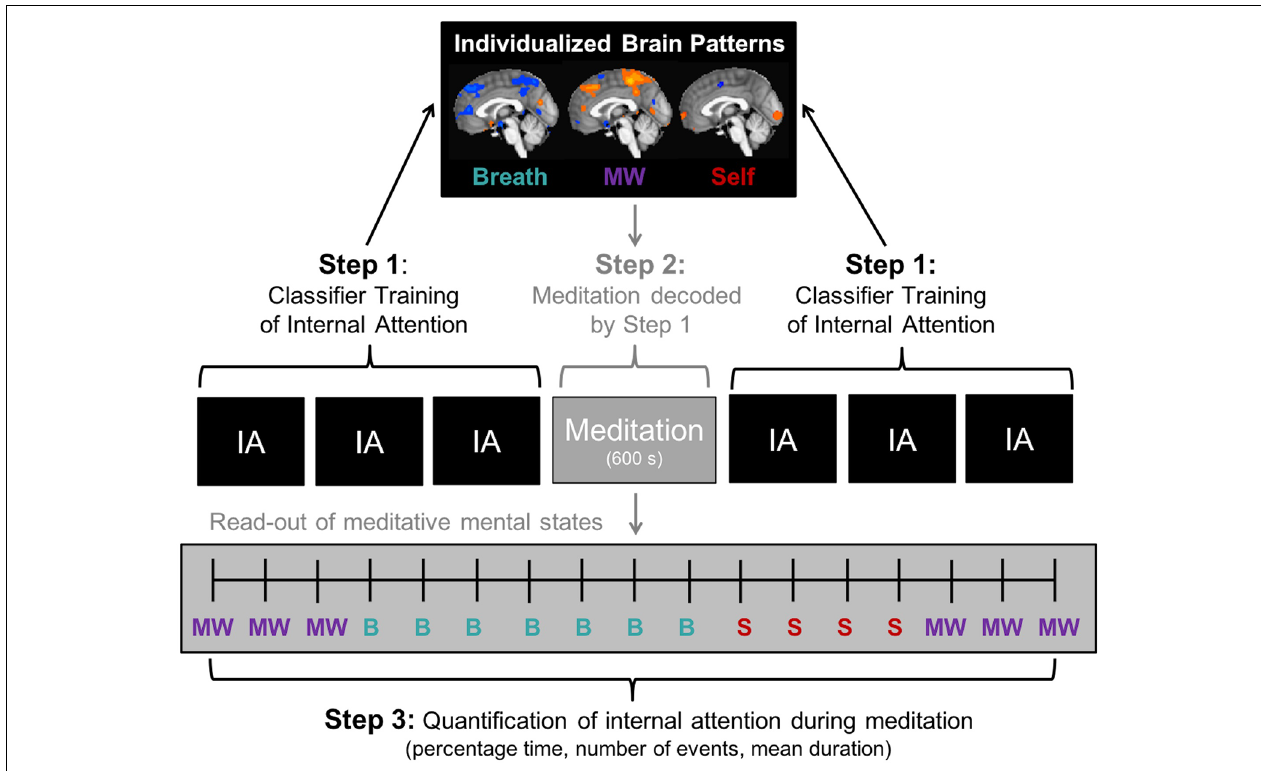
FIGURE 1 | EMBODY Framework: E valuating M ultivariate Maps of Body Awareness to measure internal attention (IA) states during meditation. Step 1 . Brain pattern classifier training. Machine learning algorithms are trained in fMRI neural patterns associated with internal mental states in the IA task. IA is directed via auditory instructions to pay attention with eyes closed to the breath, mind wandering (MW) self-referential processing (Self), and control conditions of attention to the feet and ambient sounds (see Figure 2 ). Individualized brain patterns for each participant are learned using n-1 cross-validation with six blocks of the IA task (volume N = 2,160). Step 2 . Meditation period classification. Neural patterns are collected during a 10-min meditation period (in this case, focused attention to the breath; administered in the middle of six IA blocks), and are decoded by multi-voxel pattern analysis (MVPA) using the unique brain patterns learned in Step 1. Meditation is decoded second-by-second into mental states of attention to breath (B), MW, or self-referential processing (S), producing an estimate of distinct and fluctuating mental states during meditation. Step 3 . Quantification of internal attention during meditation. From the temporal read-out of meditative mental states in Step 2, attention metrics during meditation can be quantified and estimated including percentage time spent in each mental state, the number of times engaged in each mental state (“events”), and mean duration spent in each mental